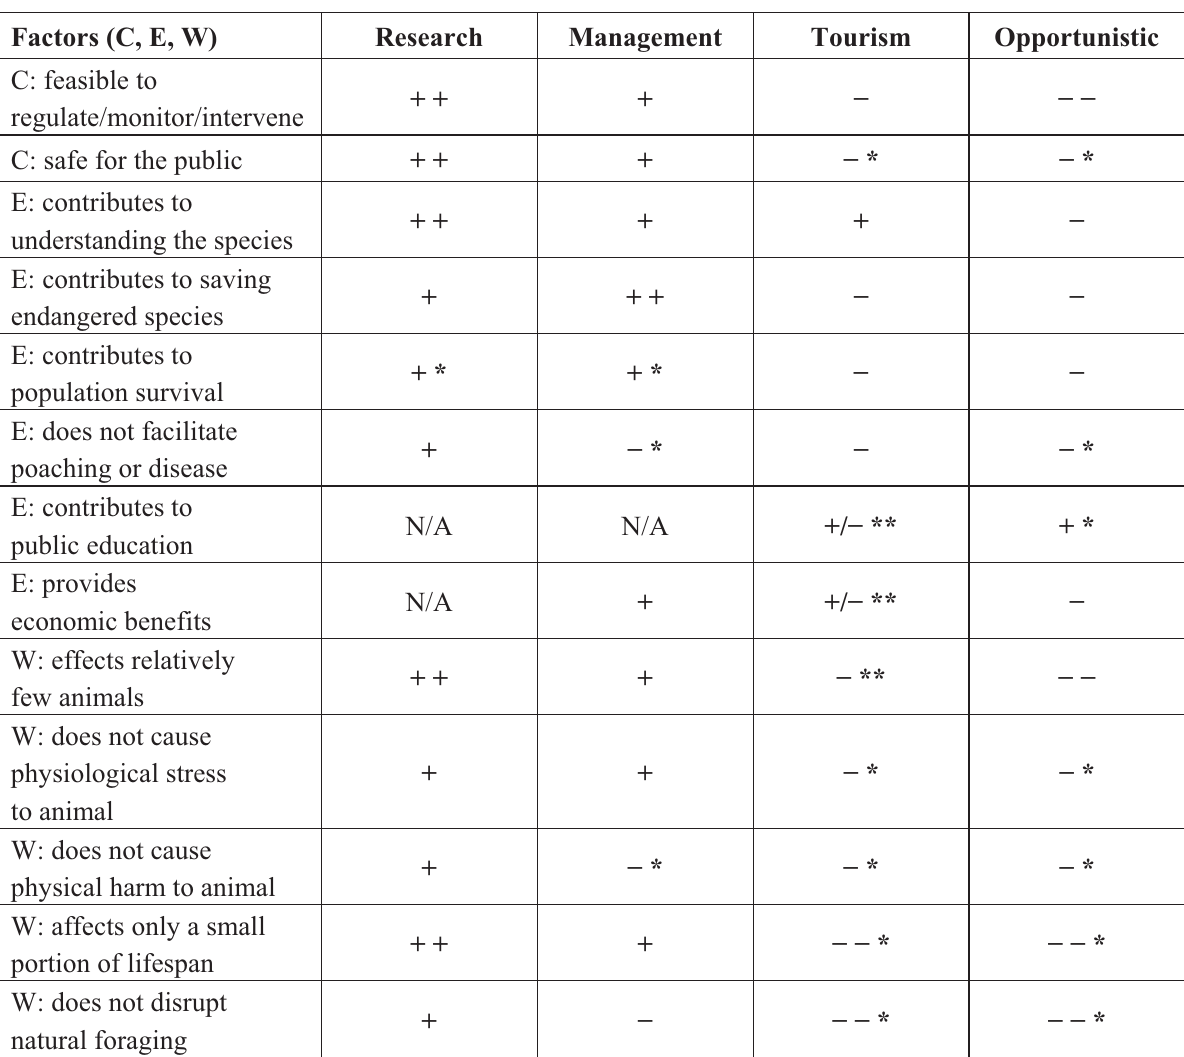
Table 1. Wildlife feeding acceptability framework: four types of feeding activities evaluated by their ability to be controlled (C) and their effects on conservation (E) and animal welfare